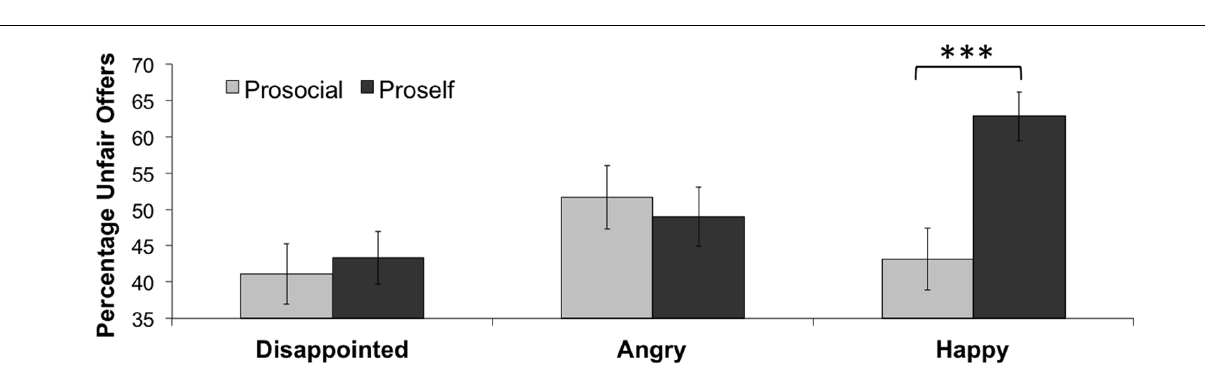
FIGURE 2 | Percentage of unfair offers for the three emotions, separate for prosocial and proself SVO. Triple asterisk ( ∗∗∗ ) indicates p <